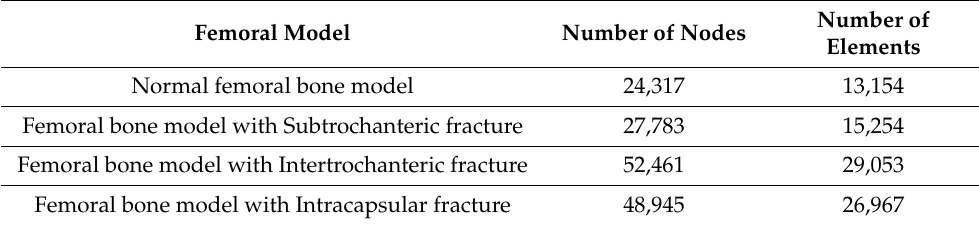
Table 1. Number of nodes and elements per femur model. Femoral Model